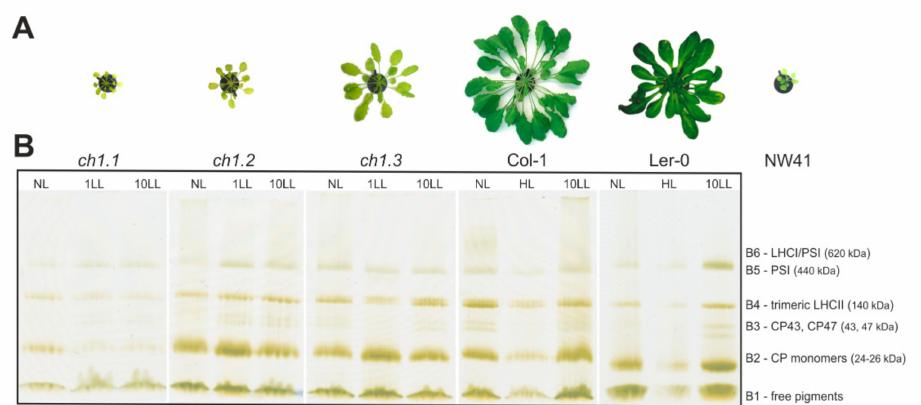
Figure 1. Characterization of Arabidopsis plant phenotypes and analysis of the composition and arrangement of chlorophyll– protein (CP) complexes: ( A )—morphological phenotypes of 8-week-old mutants ch1.1 , ch1.2 , ch1.3 and NW41 and Arabidop- sis ecotypes: Ler-0, Col-1, in normal light (NL) conditions; ( B )—native PAGE separation of CP complexes from thylakoids of plants grown in NL, low-light (LL) and high-light (HL) conditions; 1LL, 10LL—after 1st and 10th day of treatment; the picture shows true colors; a total of 8.3 µ g of total chlorophyll was loaded into each well; interpretation of bands indicated in the figure. NW41 analysis was impossible due to a lack of material with acceptable